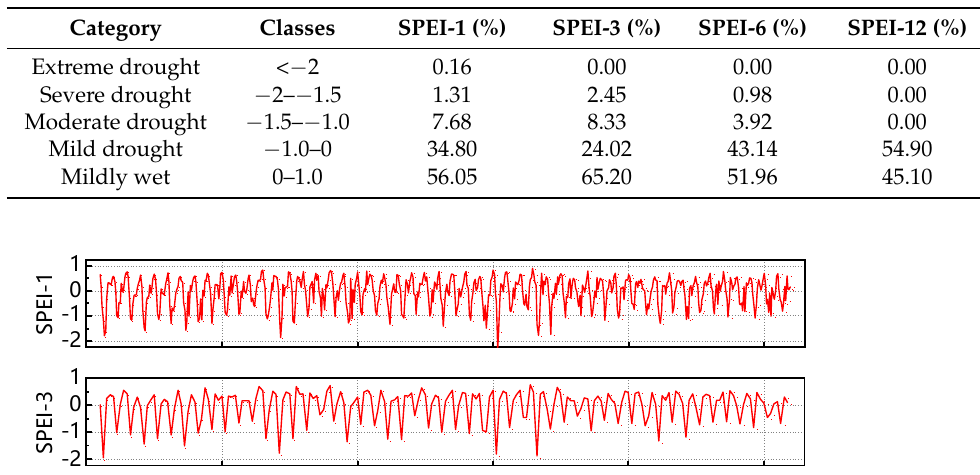
Table 4. Classification of the SPEI on the TP in 1966–2016.